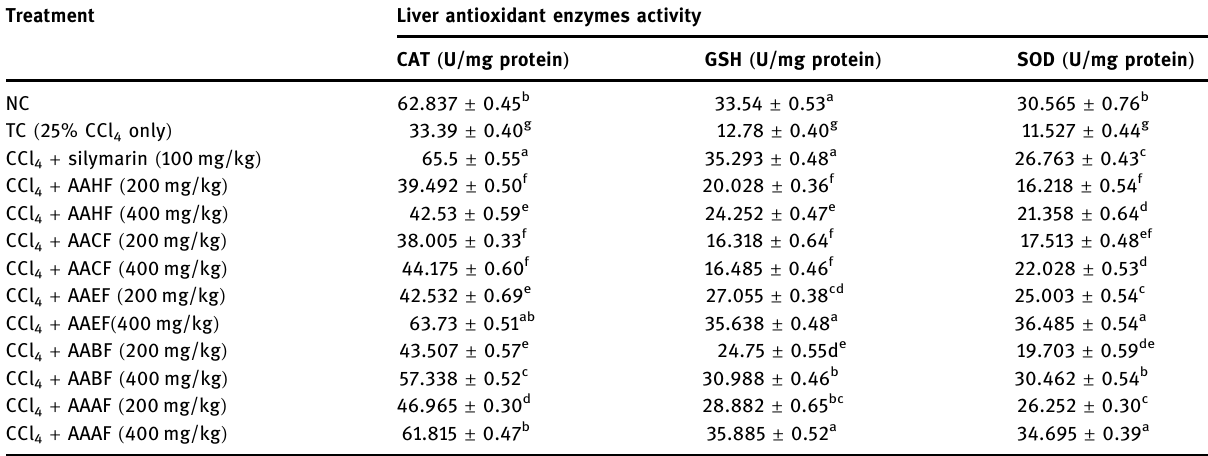
Table 2: E ff ect of di ff erent solvent fractions of AAME on antioxidant enzyme activity against CCl 4 - induced toxicity in mice Treatment